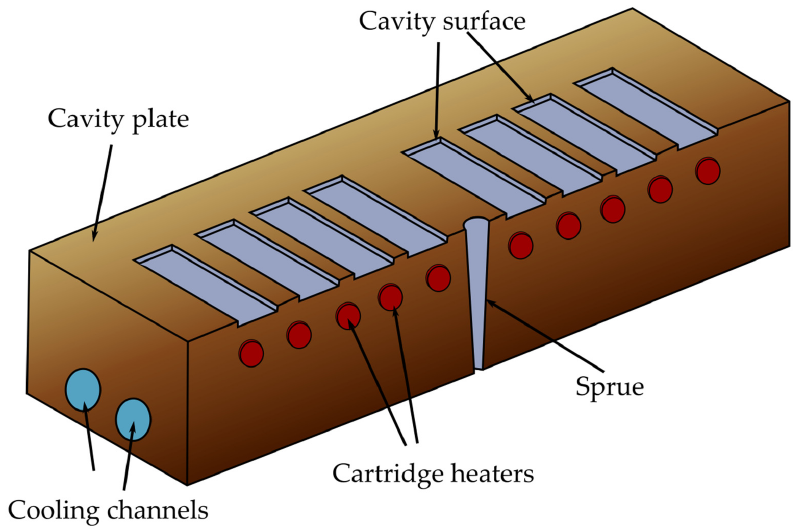
Figure 18. Location in RHCM for heaters and cooling